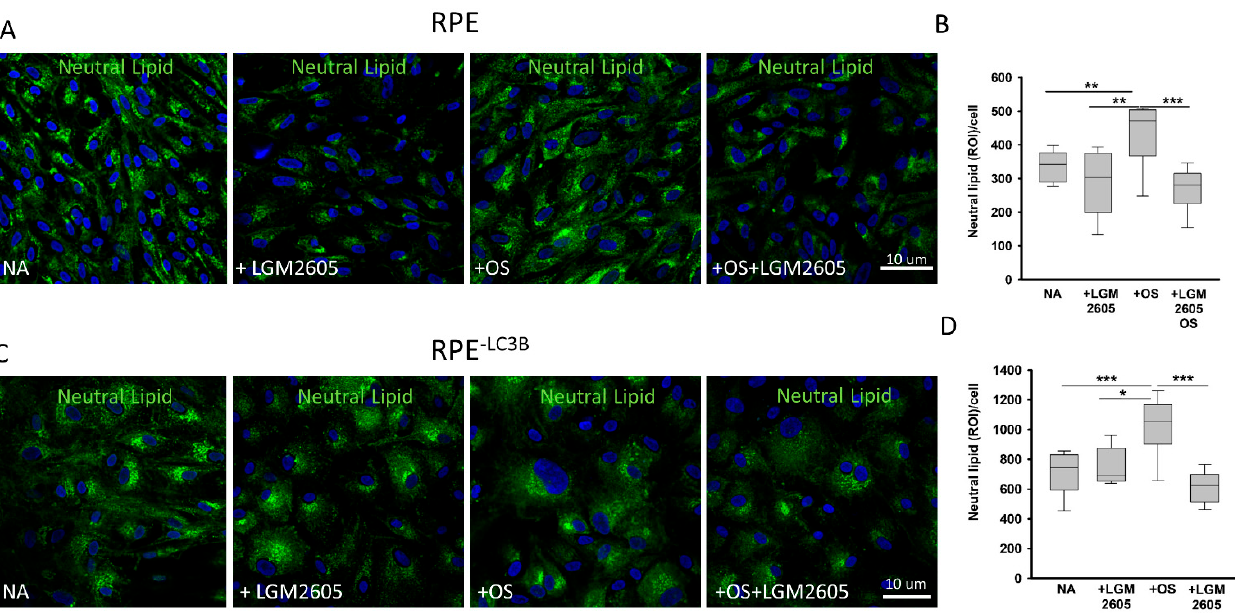
Figure 3. LGM2605 diminishes intracellular neutral lipid accumulation and peroxidation ( A – D ). ( A ) Representative confocal image of neutral lipid deposits (green) detected by staining with BODIPY493/503 and nuclei (blue) stained with Hoechst33342. RPE cells at day 7. Each day of a 7- day long study, cells were either left untreated, pretreated with LGM2605 (100 µ M), or challenged with OS, with or without (LGM2605 (100 µ M) pretreatment. ( B ) The intensity of BODIPY493/503 staining was quantified and puncta localized as indicated. Plots show data for three independent experiments, each done in triplicate. Two-way ANOVA was used for comparison across the conditions tested, and post-hoc pairwise comparison using Holm-Sidak correction was used. For each independent experiment, we analyzed 5- fields of cells each containing at least 20 cells. ** indicates, p < 0.020 and *** indicates p < 0.001. ( C ) Representative confocal image of neutral lipid deposits (green) detected by staining with BODIPY493/503 and nuclei (blue) stained with Hoechst33342 in RPE -LC3B cells at day 7. Cells were either left untreated, treated with LGM2605 (100 μ M), OS, or LGM2605 (100 μ M) + OS. ( D ) The intensity of BODIPY493/503 staining was quantified and puncta localized as indicated. Plots show data for three independent experiments, each done in triplicate. Two-way ANOVA was used for comparison across the conditions tested, and post-hoc pairwise comparison using Holm–Sidak correction was used. For each independent experiment, we analyzed 5 fields of cells, each containing at least 20 cells. * indicates p < 0.050. *** indicates p <